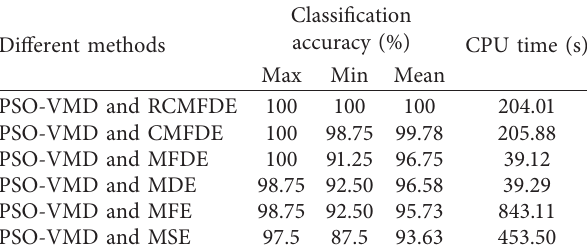
Figure 13: Classification accuracy of different methods. Table 6: The accuracy of different